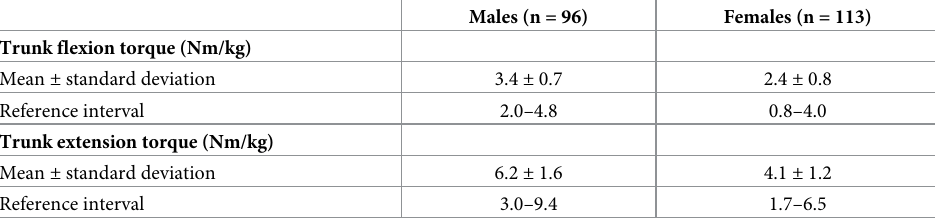
Table 3. Mean value of trunk muscle strength of healthy young adults and the estimated reference interval.